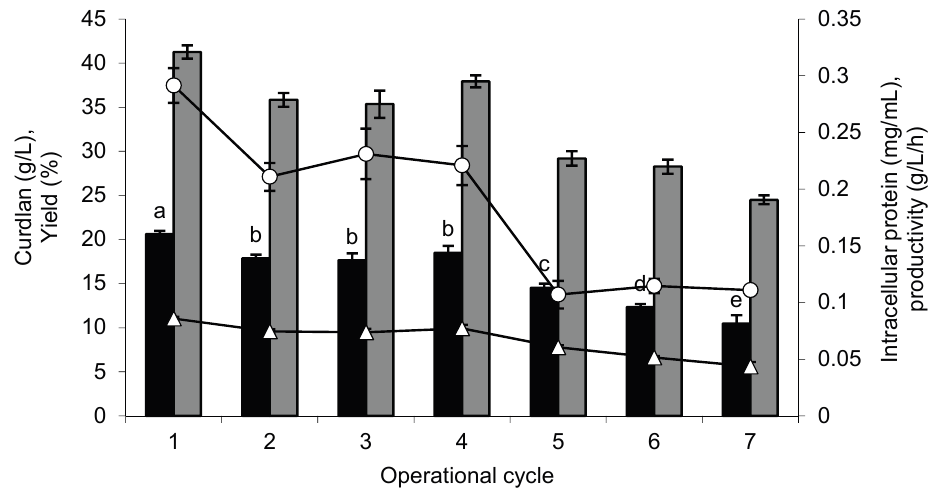
Figure 5. Curdlan production by Agrobacterium sp. IFO 13140 immobilized in loofa sponge (closed bars black), yield (closed bars gray), volumetric productivity (open triangles) and suspended biomass (open circles), in seven consecutive cycles of 10 days each at 30 °C and 150 rpm. The error bars represent standard deviations of